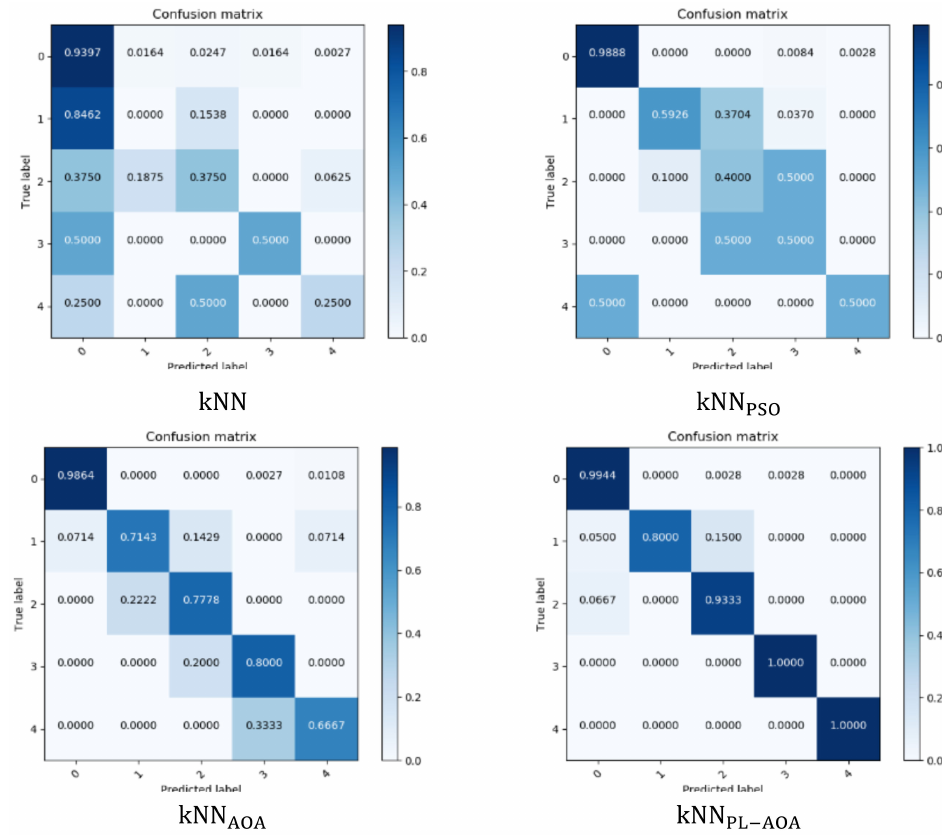
Figure 5. kNN, kNN PSO , kNN AOA , and kNN PL − AOA confusion matrix. For WSN intrusion detection systems, reducing the false positive rate is a challenge. We conducted five independent experiments using the data set. Figure 6 visually shows the comparison results of the false positive rate of the four different detection algorithms.